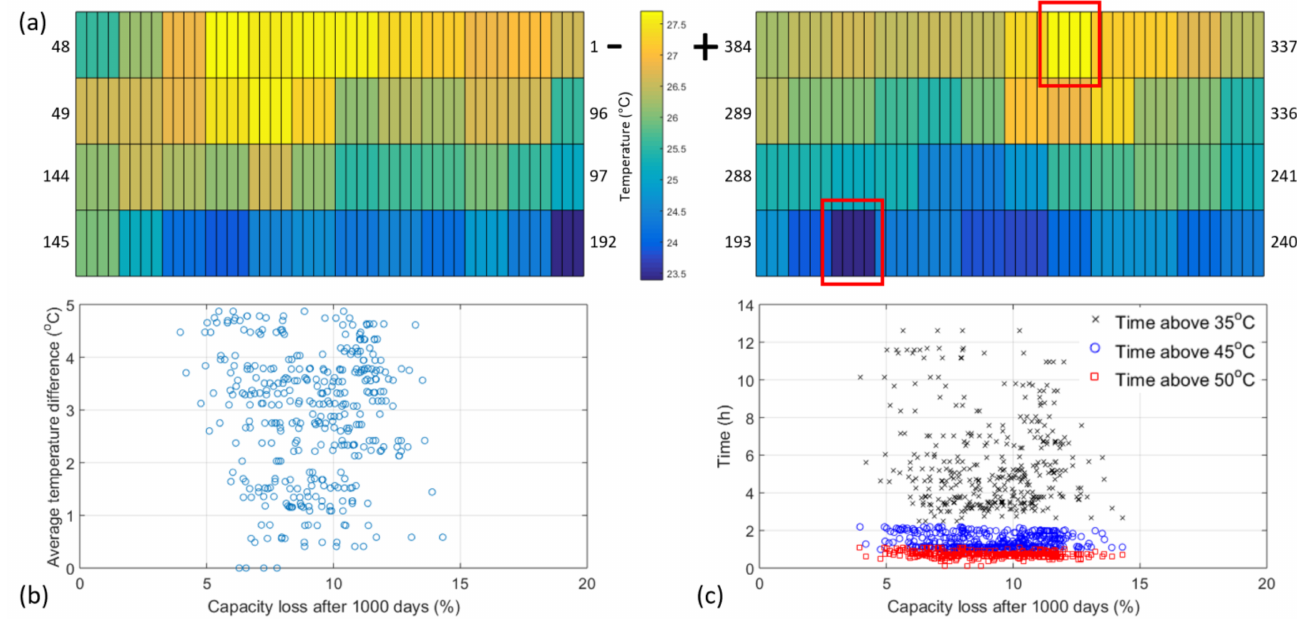
Figure 13. ( a ) Average temperature in each module for the 1st 1000 days as a function of module position in the trailer. ( b ) Average module temperature vs. capacity loss and ( c ) Time above 35 ◦ C, 45 ◦ C and 50 ◦ C as a function of capacity